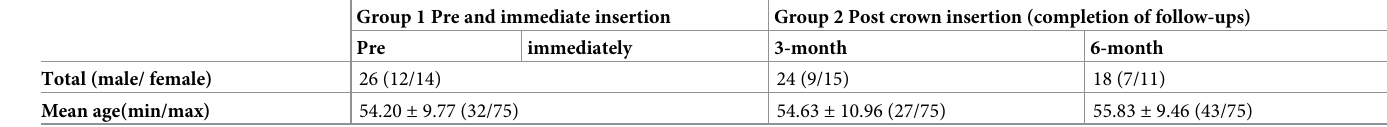
Table 1. Patients’ demographic